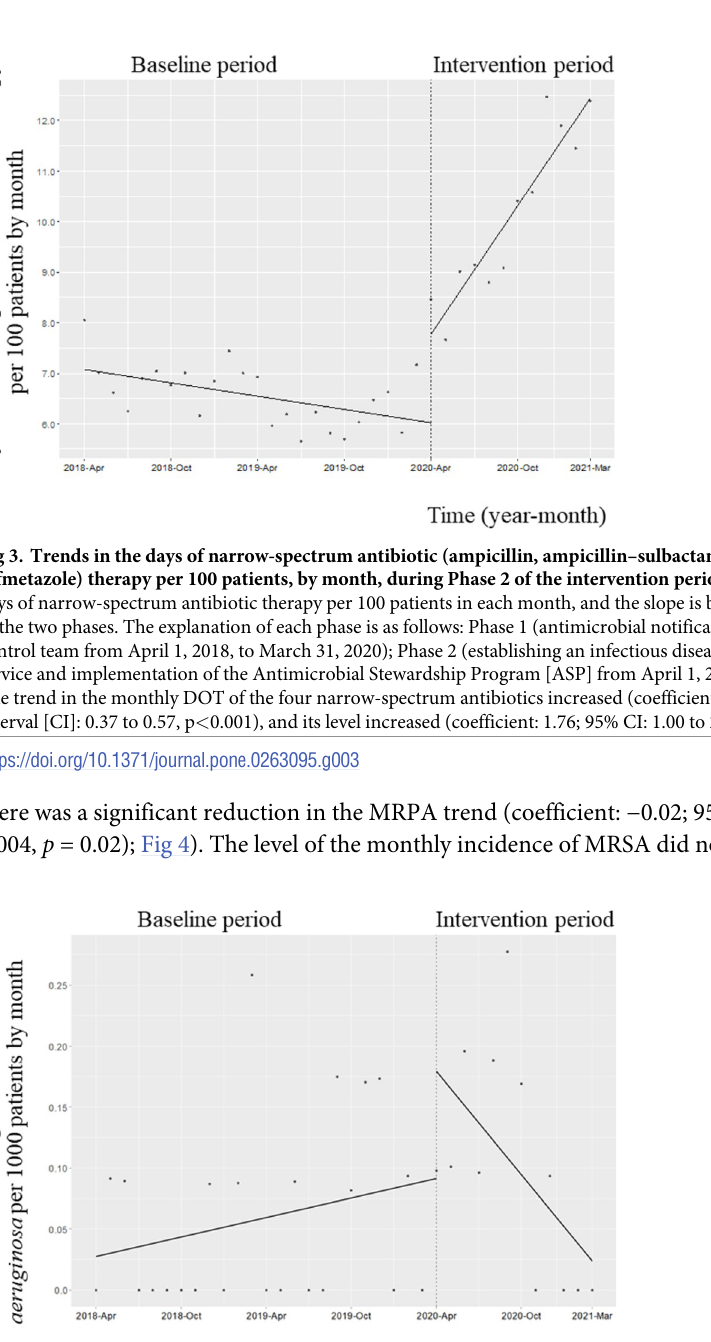
Fig 4. Trends in the incidence of multidrug-resistant Pseudomonas aeruginosa (MRPA) per 1000 patients, by month, during Phase 2 of the intervention period. Each dot refers to the incidence of MRPA per 1000 patients each month and the slope is based on linear regression in the two phases. The explanation of each phase is as follows: Phase 1 (antimicrobial notification by the infection control team from April 1, 2018, to March 31, 2020); Phase 2 (establishing an infectious disease [ID] consultation service and implementation of the Antimicrobial Stewardship Program [ASP] from April 1, 2020, to March 31, 2021). The number of isolated samples in 2018, 2019, and 2020 was 7, 9, and 13, respectively. The level of the monthly incidence of MRPA did not decrease (coefficient: 0.09; 95% confidence interval [CI]: − 0.015 to 0.19, p = 0.10), although the trend of the infection was significantly reduced (coefficient: − 0.02; 95% CI: − 0.02 to − 0.004, p =